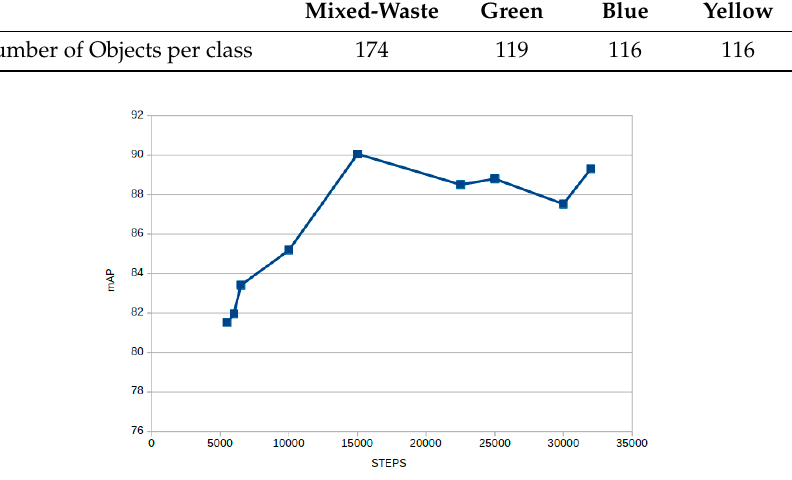
Figure 4. The mean average precision (mAP) per number of training steps.